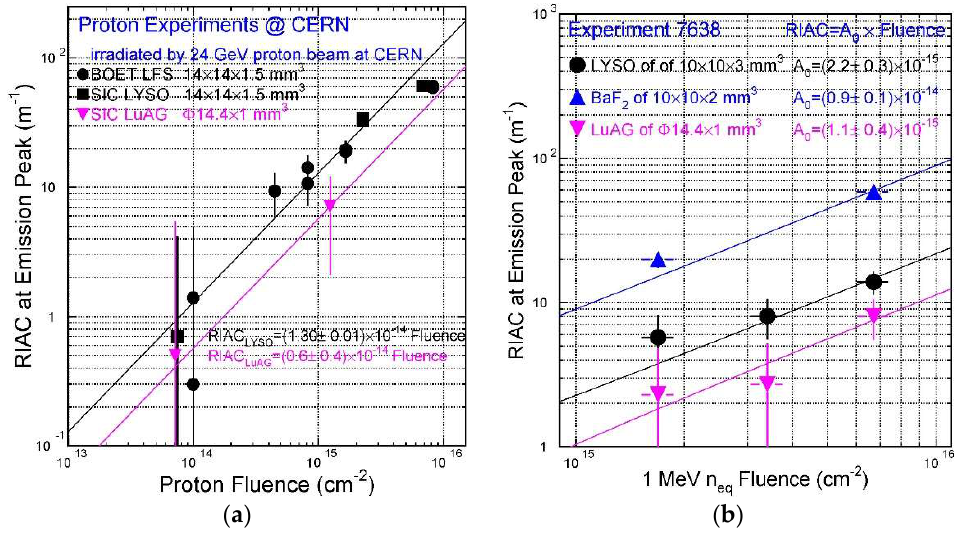
Figure 5. The RIAC values are shown as a function of ( a ) proton fluence [33] and ( b ) one MeV equivalent neutron fluence [33] for LuAG:Ce ceramics, LYSO:Ce, and BaF 2 crystals irradiated in the proton experiment at CERN PS-IRRAD and the neutron experiment 7638 at LANSCE, respectively.